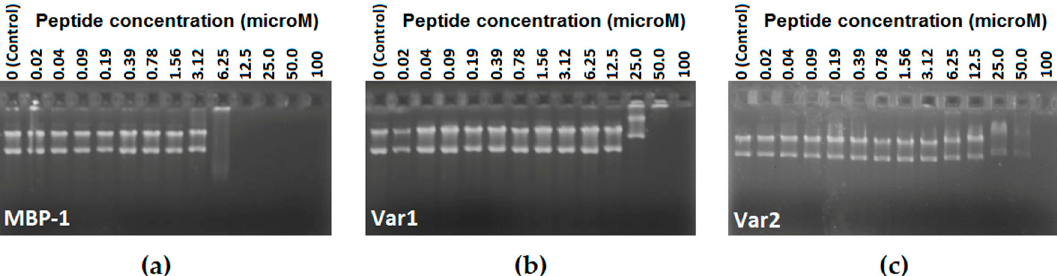
Figure 1. Binding activity assay of MBP-1 ( a ), Var 1 ( b ) and Var 2 ( c ) with plasmid DNA (pET28a+, 100 ng). The interaction of peptides with plasmid DNA was assessed by measuring the retardation of plasmid DNA migration through a 1% agarose gel. The peptide concentration indicated in each lane represents a serial increase in concentration from 0.02 µM to 100 µM. Plasmid DNA was only used as control in the 0 lane.